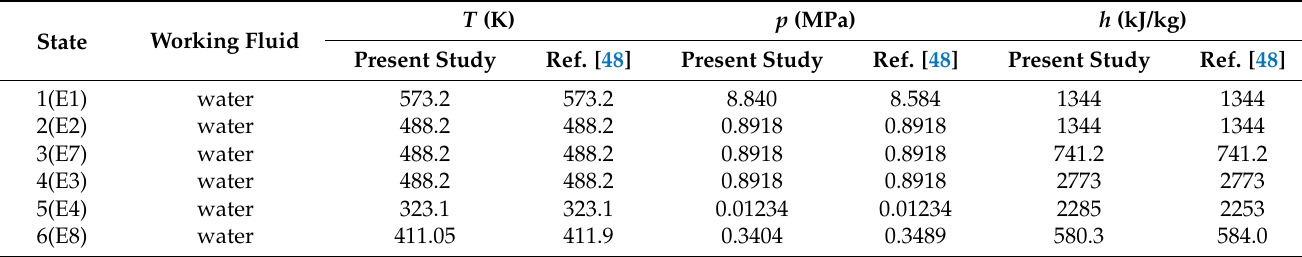
Table 1. Comparative results of SF system between this paper and a previous